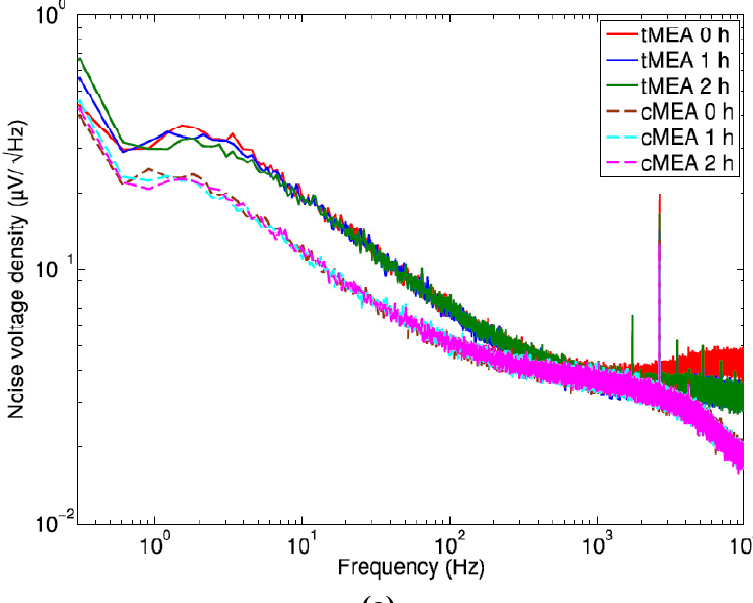
Figure 2. (a) Typical noise voltage density spectra of old tMEA and cMEA microelectrodes at times of 0 h, 1 h, and 2 h after filling the MEAs with medium. Noise voltage histograms (200 bins of width 0.2 µV) at the time of 1 h time point are presented from the same (b) tMEA and (c) cMEA